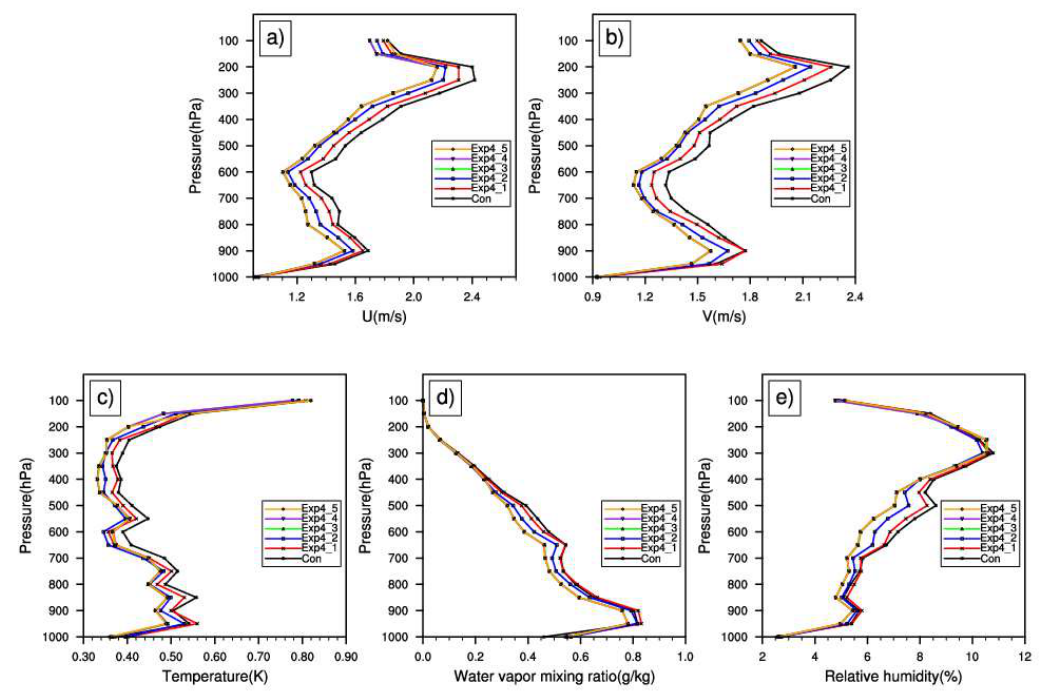
Figure 12. Vertical profiles of RMSEs in ( a ) u winds (unit: m s − 1 ) ( b ) v winds (unit: m s − 1 ) ( c ) temperature (unit: K) ( d ) water vapor mixing ratio (unit: g/kg) ( e ) relative humidity (unit: %) from the Con, Exp4_1, Exp4_2, Exp4_3, Exp4_4, and Exp4_5. Results are valid at 00:00 UTC on 29 June 2009 and are calculated for the whole horizontal domain.